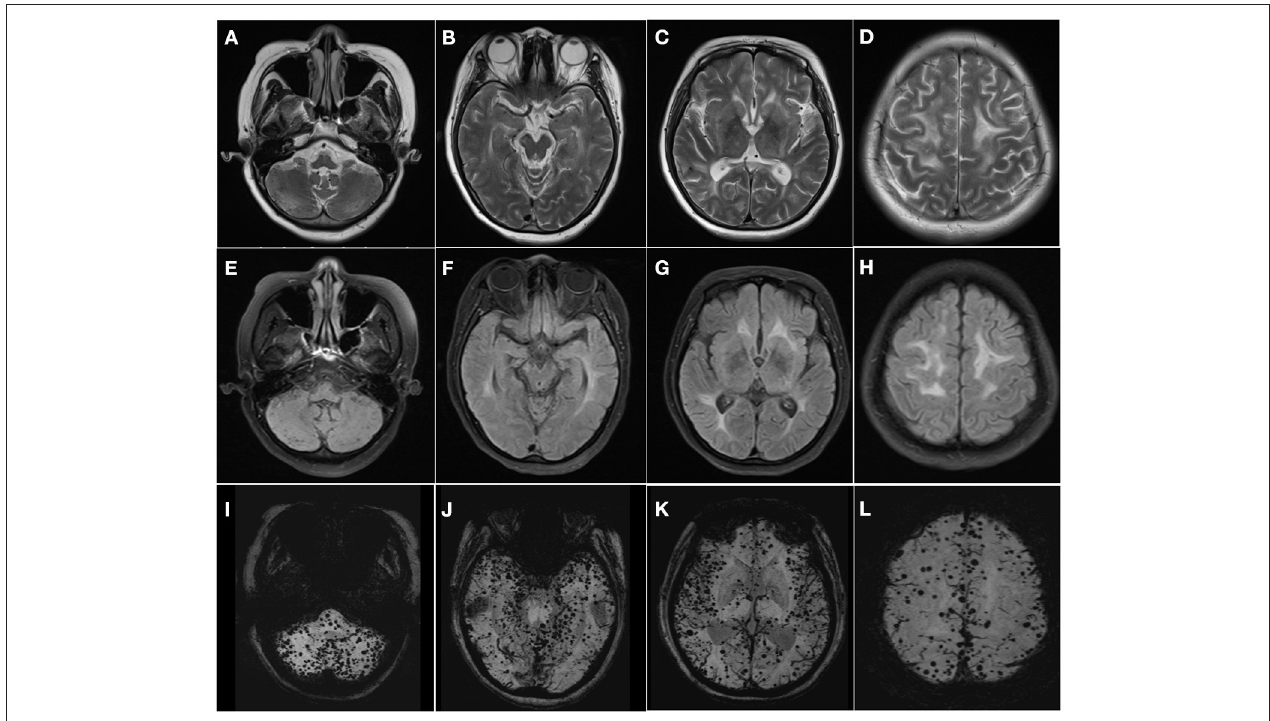
FIGURE 1 | Multiple hyperintensities in the cerebral white matter extending from supra- to infratentorial regions on T2-weighted (A–D) and fluid-attenuation inversion recovery images (E–H) . Susceptibility-weighted imaging shows diffuse microbleeds in the cerebellum, brain stem, subcortex, and cortex (I–L)